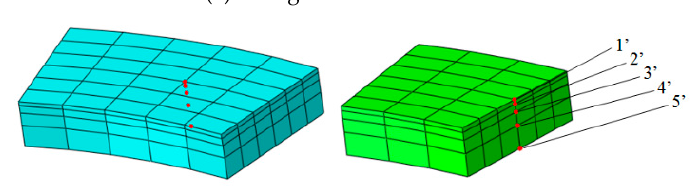
Figure 7. Distributions of nodes along the different paths of brake shoe.